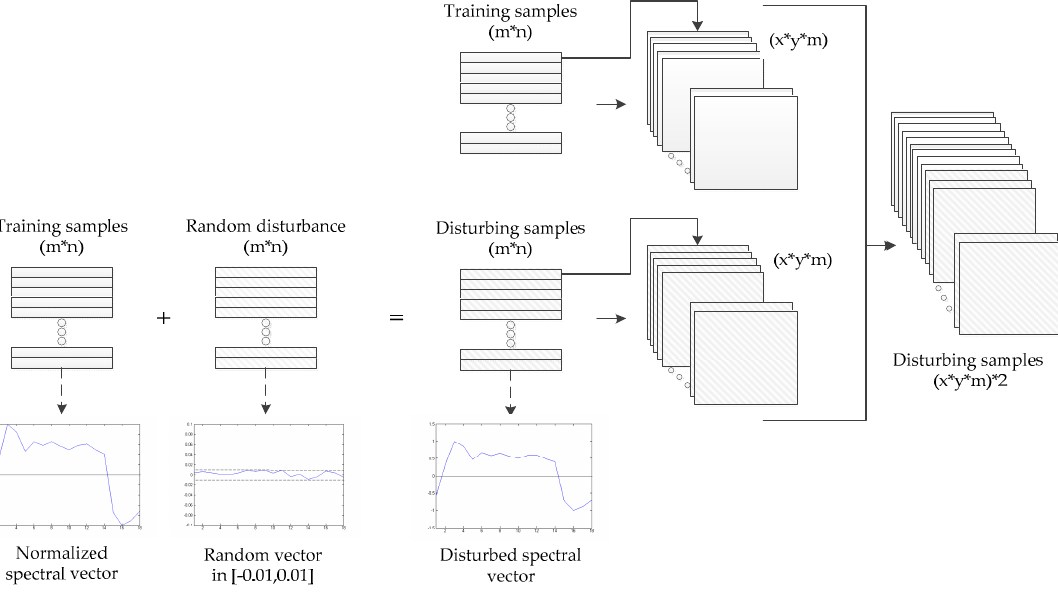
Figure 4. Increase the training sample. The disturbance sample data is generated by adding a random disturbance to the original sample. It shows an example of generating a data of 2x training samples. (The number of training samples: m = 6090, the spectral dimension: n = 36, and x = y = 6.).